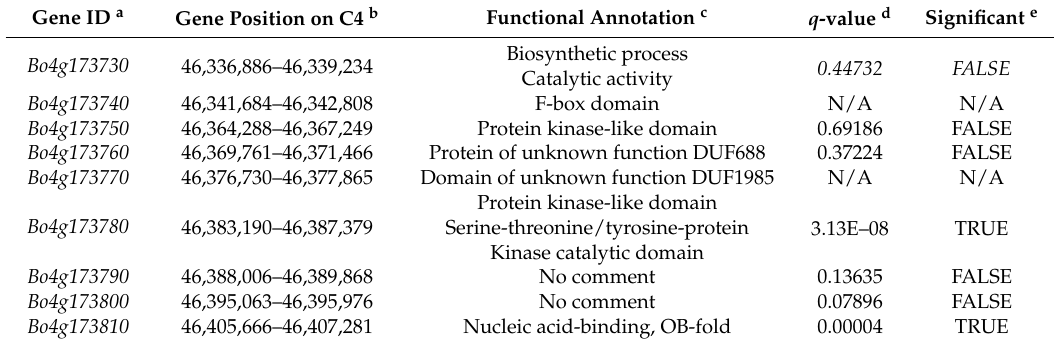
Table 2. Annotations and changes in the expression of genes in the mapping region of BoHL2